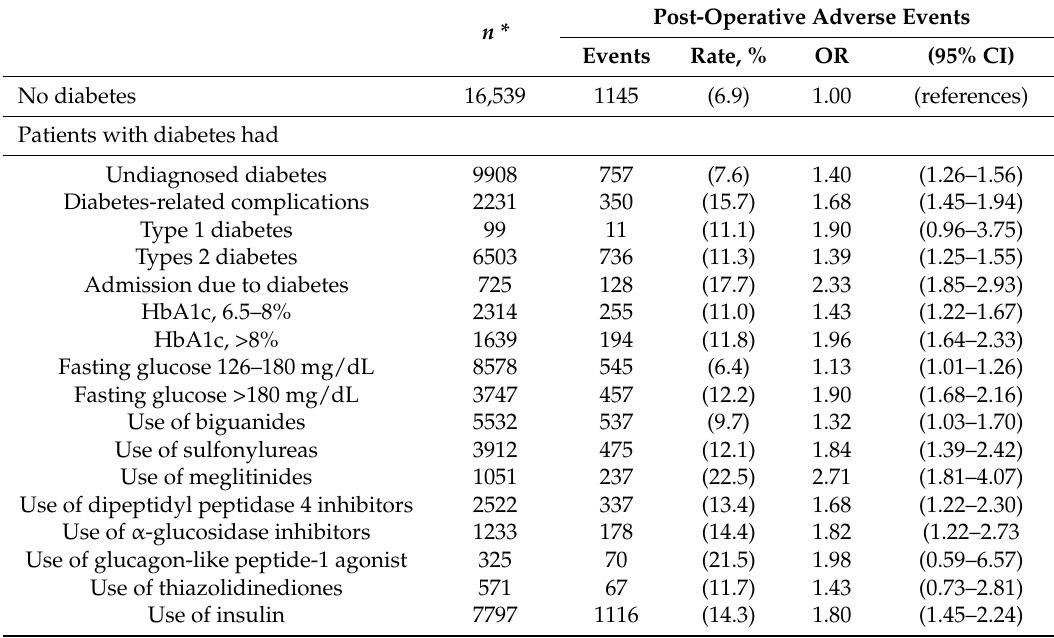
Table 4. The risk of post-operative adverse events in patients with various severities of